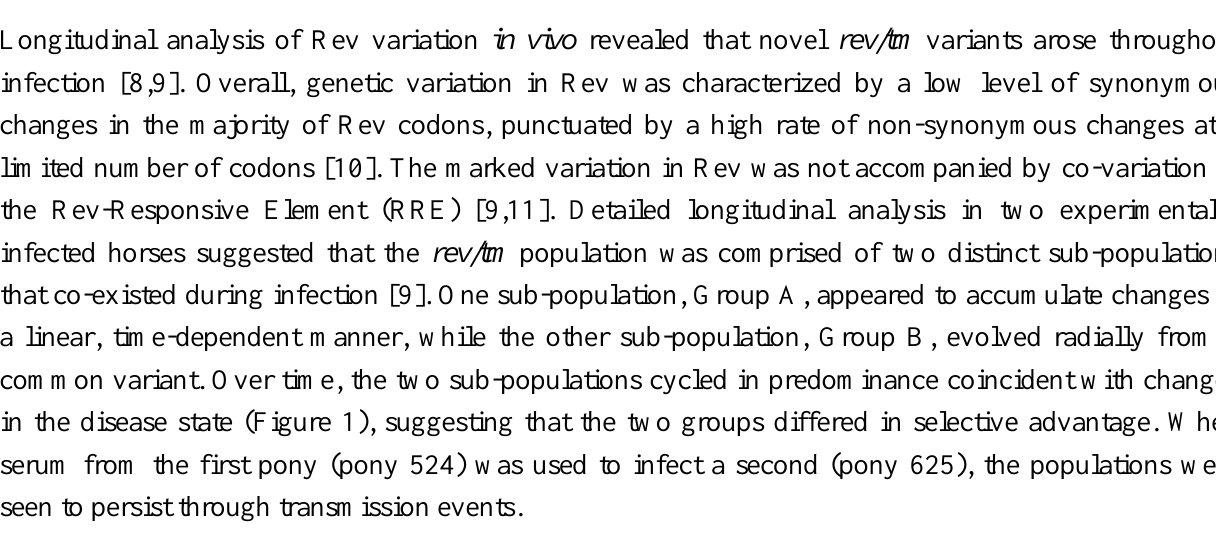
Figure 1. Partition analysis identifies two co-existing sub-populations of rev variants